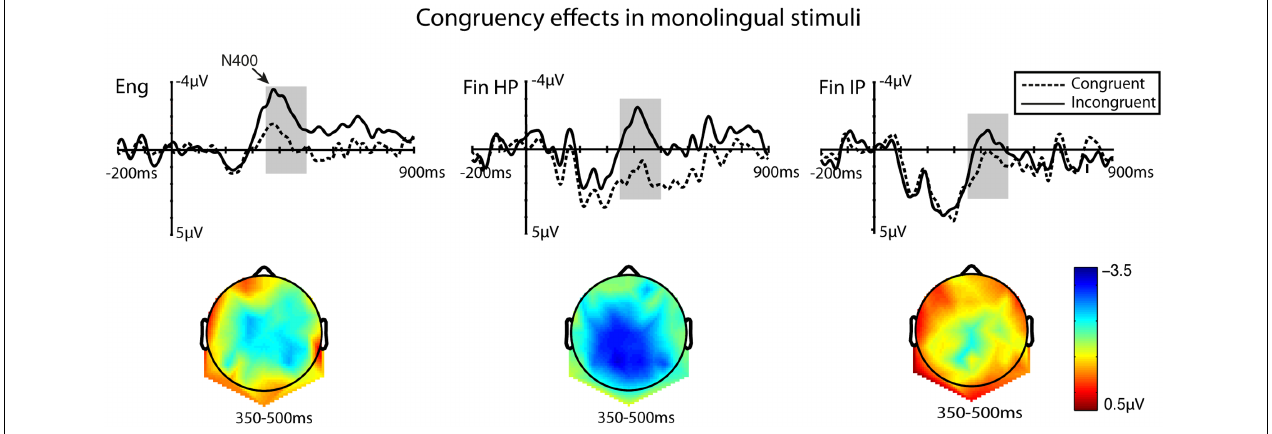
FIGURE 1 | Grand-average waveforms taken from a region of interest (ROI) consisting of a set of nine centro-parietal electrodes. Each of the two non-switched conditions is plotted for the three groups: semantically congruent (dashed lines) and semantically incongruent (continuous lines). Accompanying scalp maps were obtained for the 350–500 ms time windows for the averaged values of difference waves (incongruent minus congruent). The x -axis represents time in milliseconds, and the y -axis represents amplitude in microvolts. The 200 ms baseline is plotted, and time 0 marks the onset of the target word.